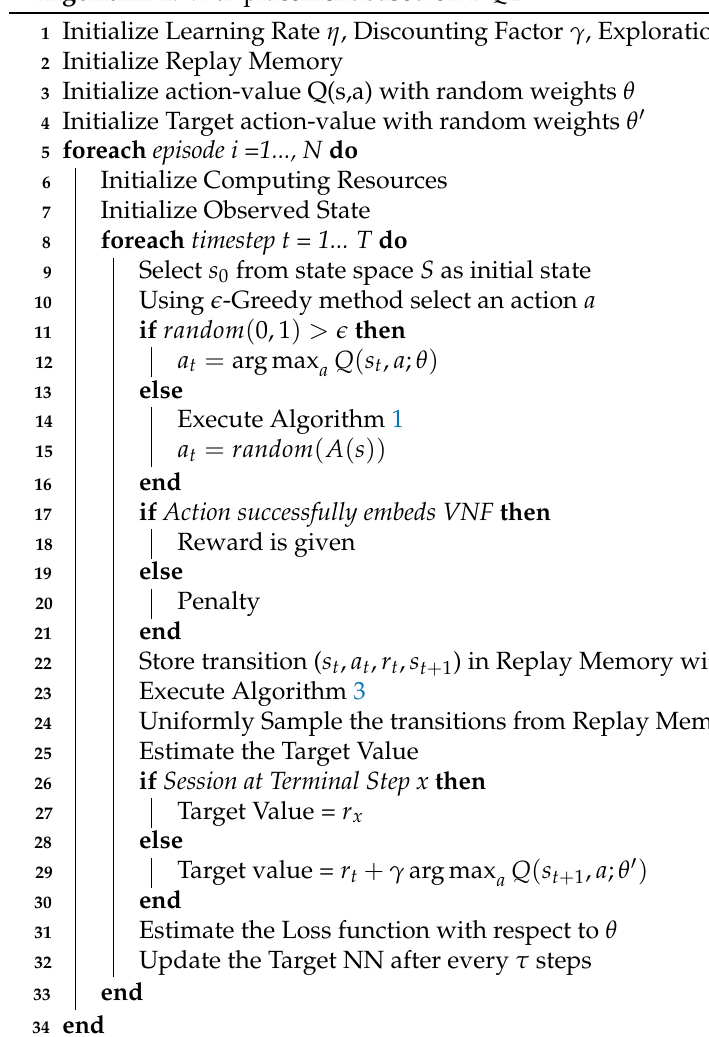
Algorithm 2: VNF placement based on